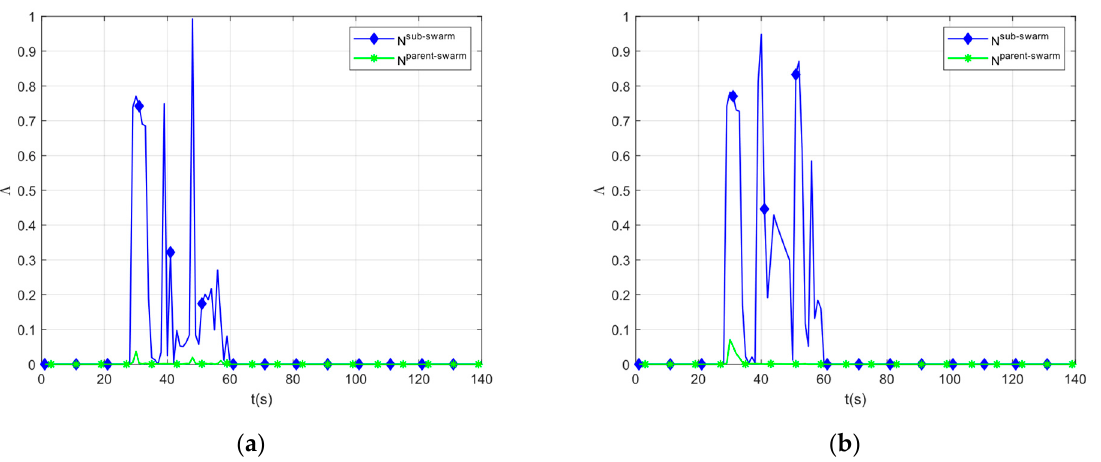
Figure 8. Divergence indices in the fission–fusion process of UAV swarm under the anti-catch situation.